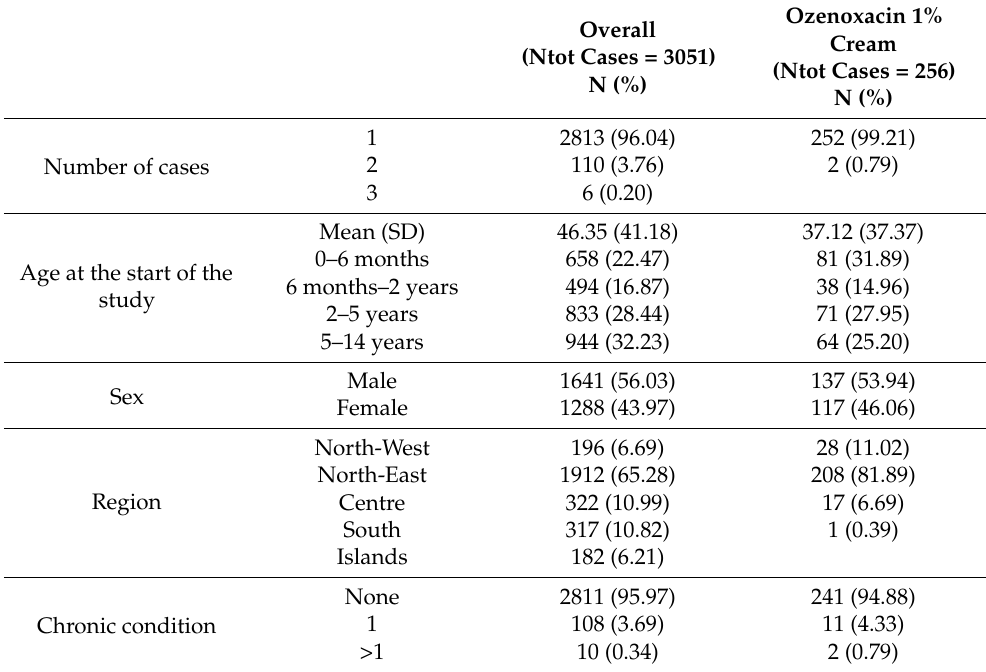
Table 1. Sociodemographic and clinical characteristics of the children included in the study (N = 2929 overall children, N = 254 children prescribed ozenoxacin). Pedianet,